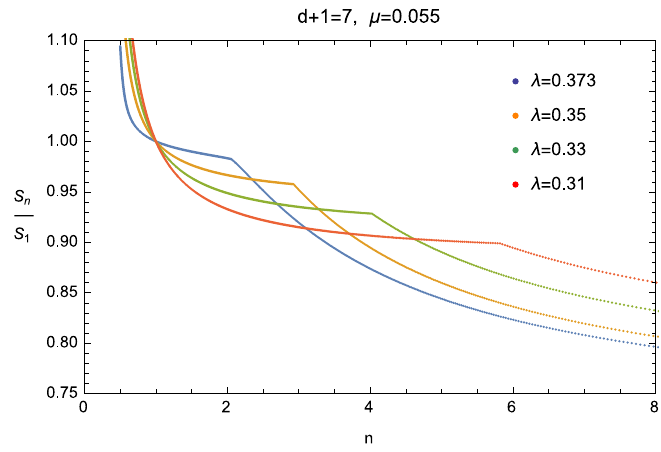
Figure 4. Ratio of R(cid:19)enyi entropy to the entanglement entropy as a function of n in 7-dimensions for a (cid:12)xed (cid:22) = 0 : 055 and (cid:21) = 0 : 0373 ; 0 : 35 ; 0 : 33 ; 0 : 31 from top to bottom. Lovelock parameters have been chosen from the causal region in parameter space where the phase transition in the bulk occur, (cid:12)gure 3. Therefore, each curve displays a kink in the R(cid:19)enyi entropy at n c = T 0 =T c . The kink appears at larger n c for smaller (cid:21) and moves to the left towards n = 1 as (cid:21) grows. Note that for (cid:22) = 0 : 055 an upper bound from boundary causality, i.e. (cid:21) (cid:20) 0 : 373, imposes a lower bound on n c (cid:21) 2 :